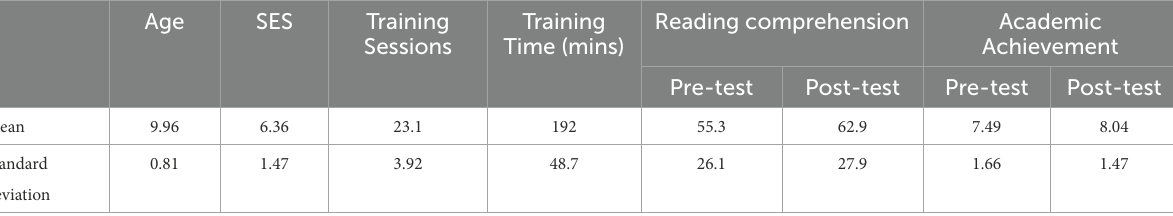
TABLE 1 Descriptive data for the dependent variables and co-variables of